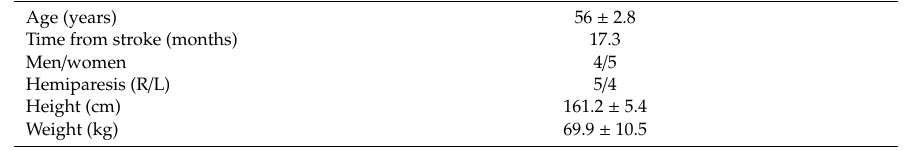
Table 1. Subjects’ characteristics and the inclusion criteria (n =